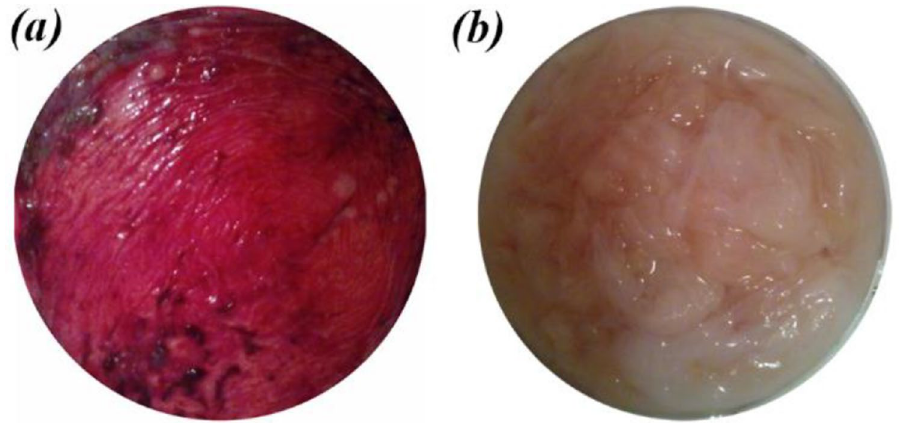
Figure 1. Human amnion membrane ( a ) before washing, ( b ) after